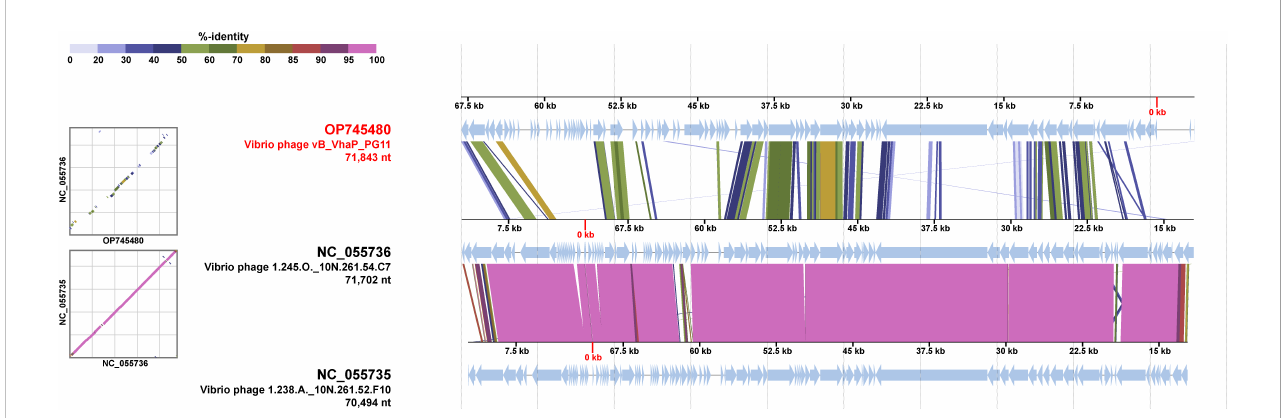
FIGURE 4 Genomic comparisons between Vibrio phage vB_VhaP_PG11, Vibrio phage 1.245.O._10N.261.54.C7, and Vibrio phage 1.238.A._10N.261.52.F10. The shading below each genome indicates sequence similarities between the genomes, with different colors representing the levels of similarity.